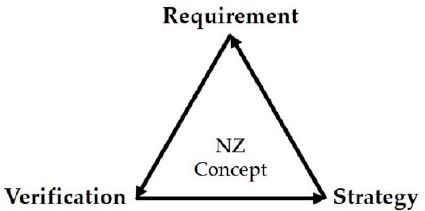
Figure 2. Schematic net zero clarification diagram.